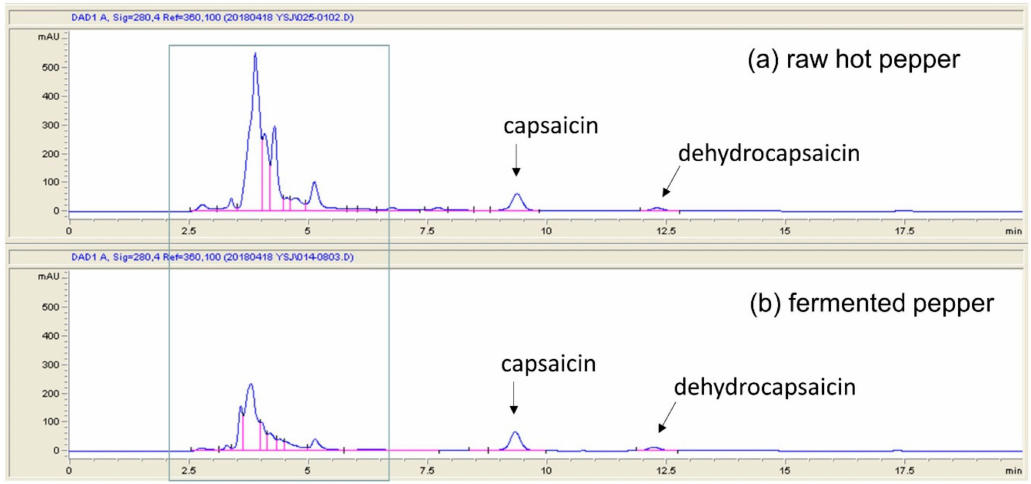
Figure 1. The chromatogram of raw hot pepper and fermented